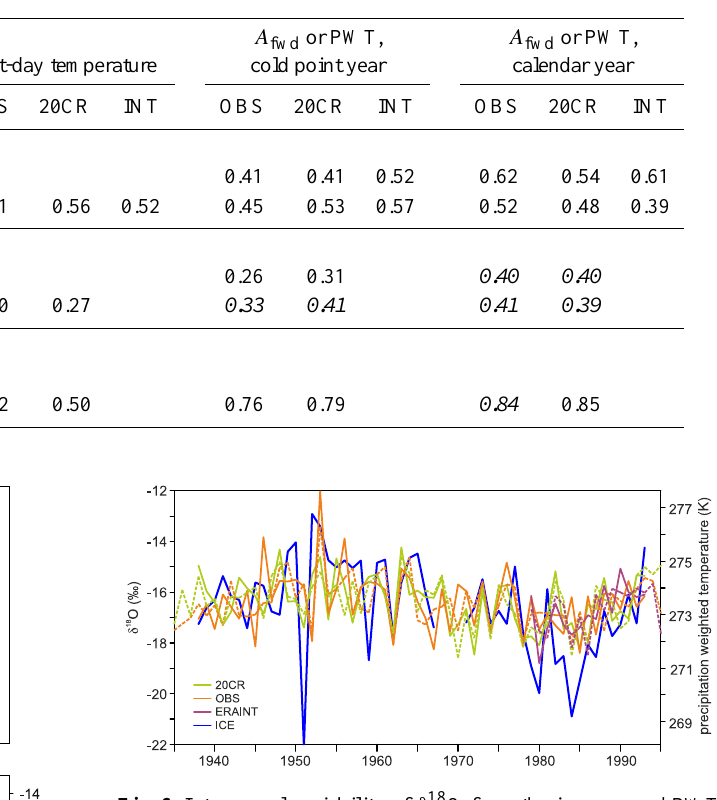
Fig. 6. Interannual variability of δ 18 O from the ice core and PWT from forward modelling (solid: cold point year, dashed: calendar year) based on different data